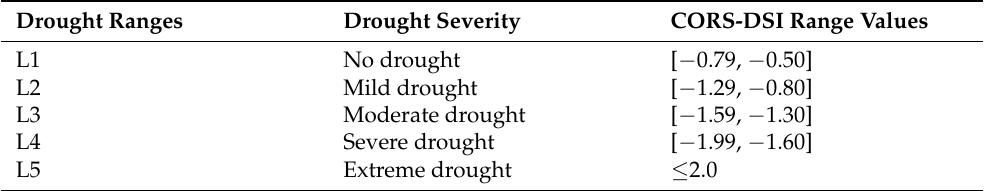
Table 6. Correlation coefficients and WRMS (%) between different mass surface loads and the reconstructed geodetic height time series.